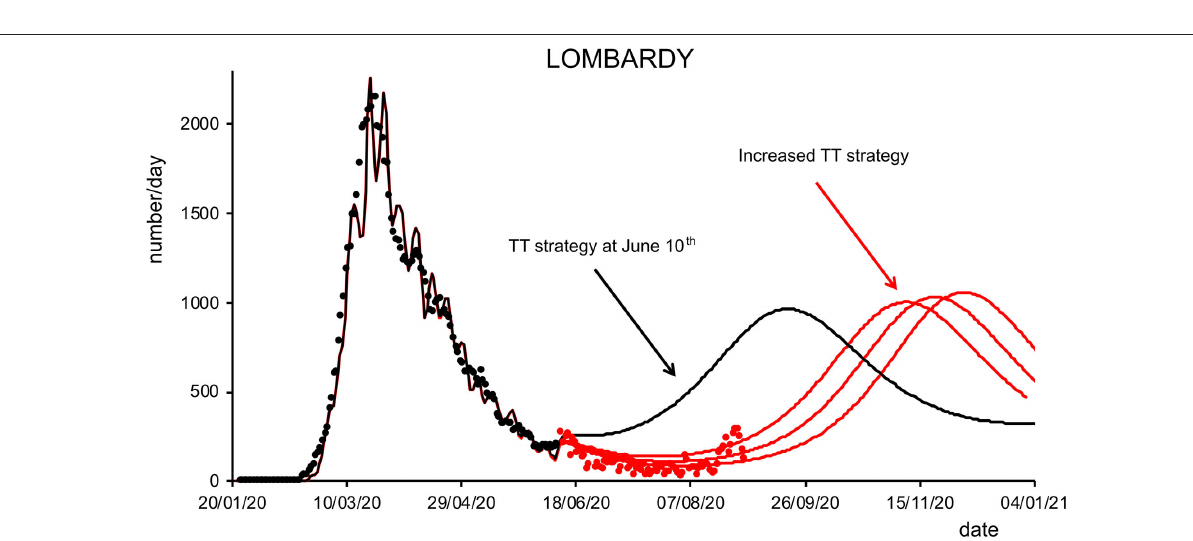
FIGURE 6 | Effects of testing and tracking strategies in Lombardy. Black dots are daily data from January 22 to June 10 (7-day sliding window averages) of positive cases reported by the “National Civil Protection Agency” for Lombardy. The black line represents the posterior expectation for the same quantity following model inversion. Colored lines represent the predicted number of positive cases under increasing levels of testing and tracking, starting from the level that the model inferred to be the one adopted on June 10, to 12% (first red trace), 18% (middle red trace), and 24% (right red trace) of the maximum efficacy (see Methods). Red dots represent daily data from June 11 to August 31 (7-day sliding window